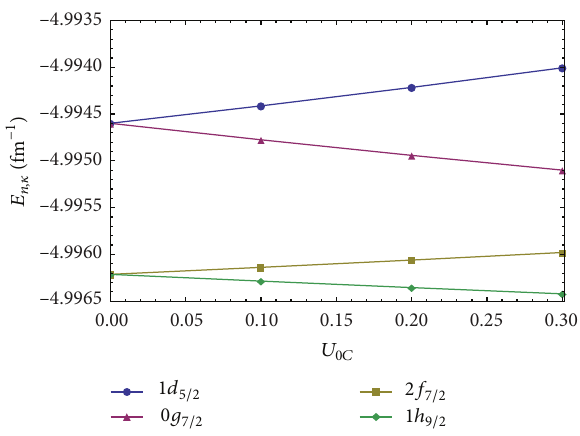
Figure 5: The variation of the energy spectrum 𝐸 𝑛,𝑘 for tensor Hulth´en potential in the case of p-spin symmetry according to the screening parameter 𝛿 . Here we selected 𝑈 0𝐻 = 0.1 , 𝛼 = 0.01 .